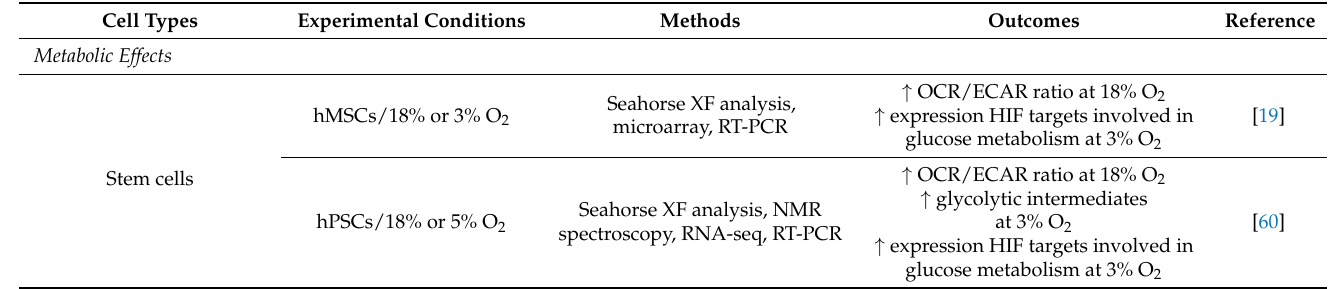
Table 1. Effects of O 2 tension (between 2–18% O 2 ) on cellular metabolism, mitochondrial abundance, morphology, and network